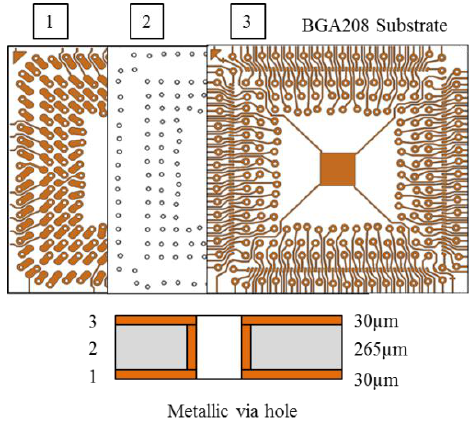
Figure 2. BGA208’s laminate description. Figure 2. BGA208‘s laminate description.